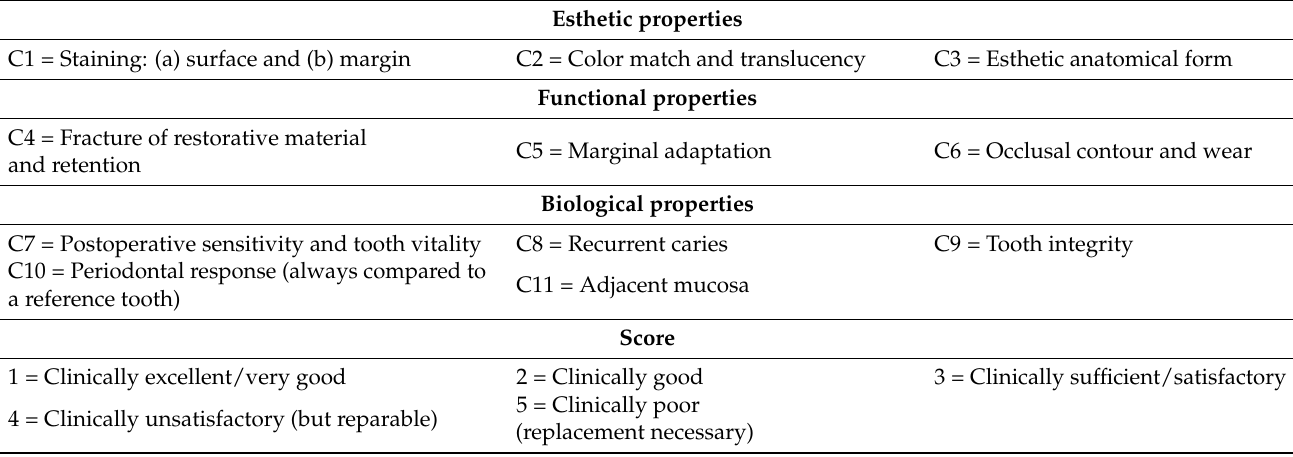
Table 1. List of FDI World Dental Federation criteria used in our study to assess the esthetic, functional, and biological properties for the clinical evaluation of indirect